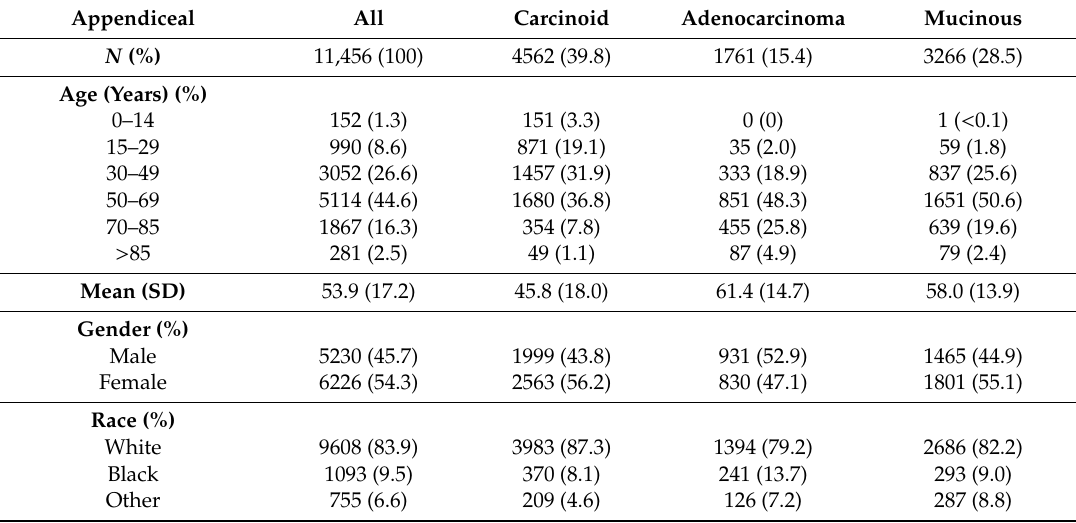
Table 13. Baseline demographics and clinical characteristics by histology for appendiceal